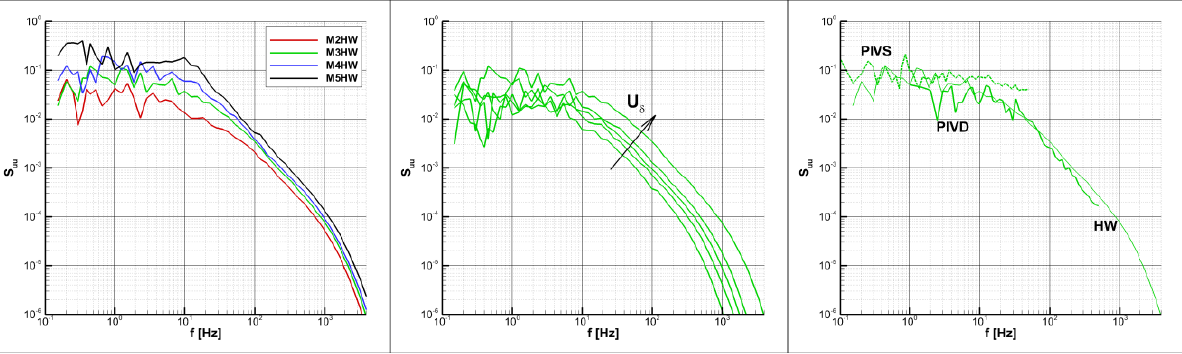
Fig. 3. Dependence of the power spectral density on the surface roughness, HW data, U δ =10m/s, z/δ=0.33 (left); dependence on the free stream velocity, HW data, setup M3, z/δ =0.33 (middle), comparison of the spectral curves for HW, PIVS and PIVD methods setup M3, U δ =10m/s, z/δ =0.33 (left).